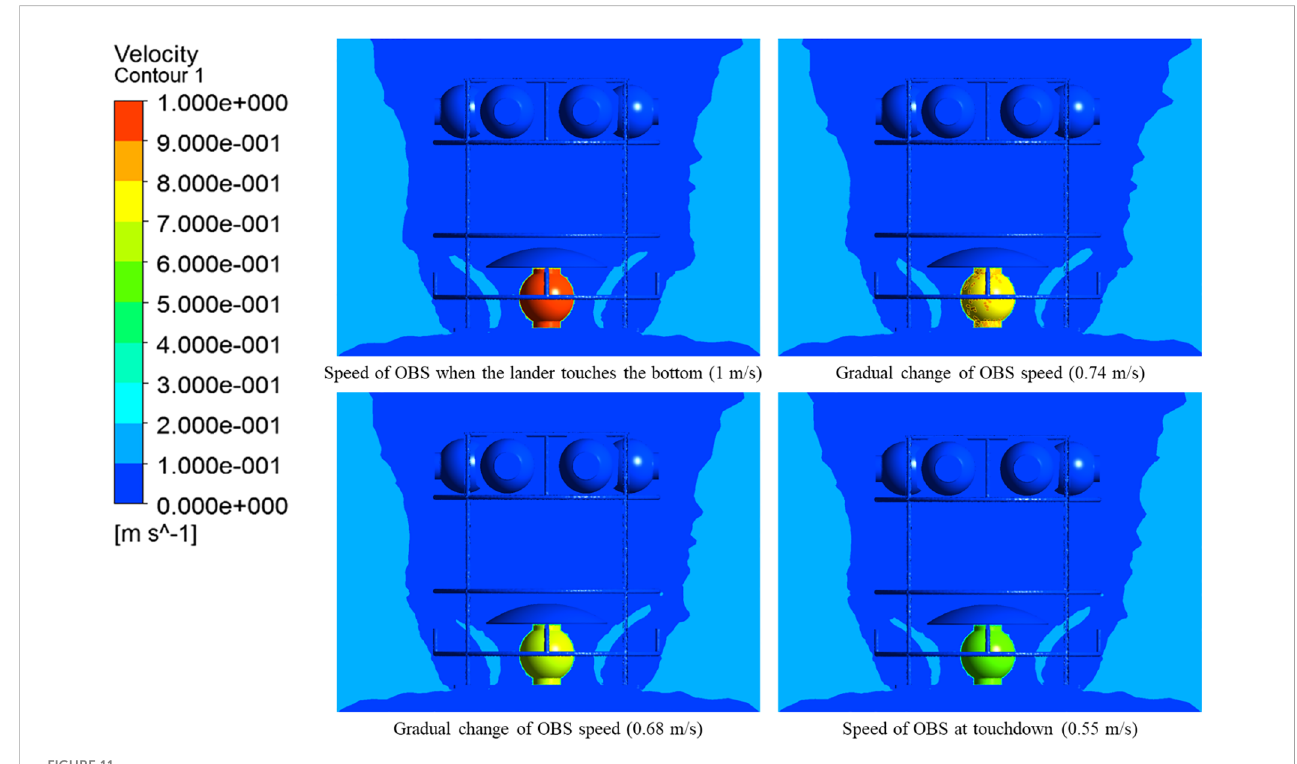
FIGURE 11 Simulation results of OBS speed when it contacts with the seabed.